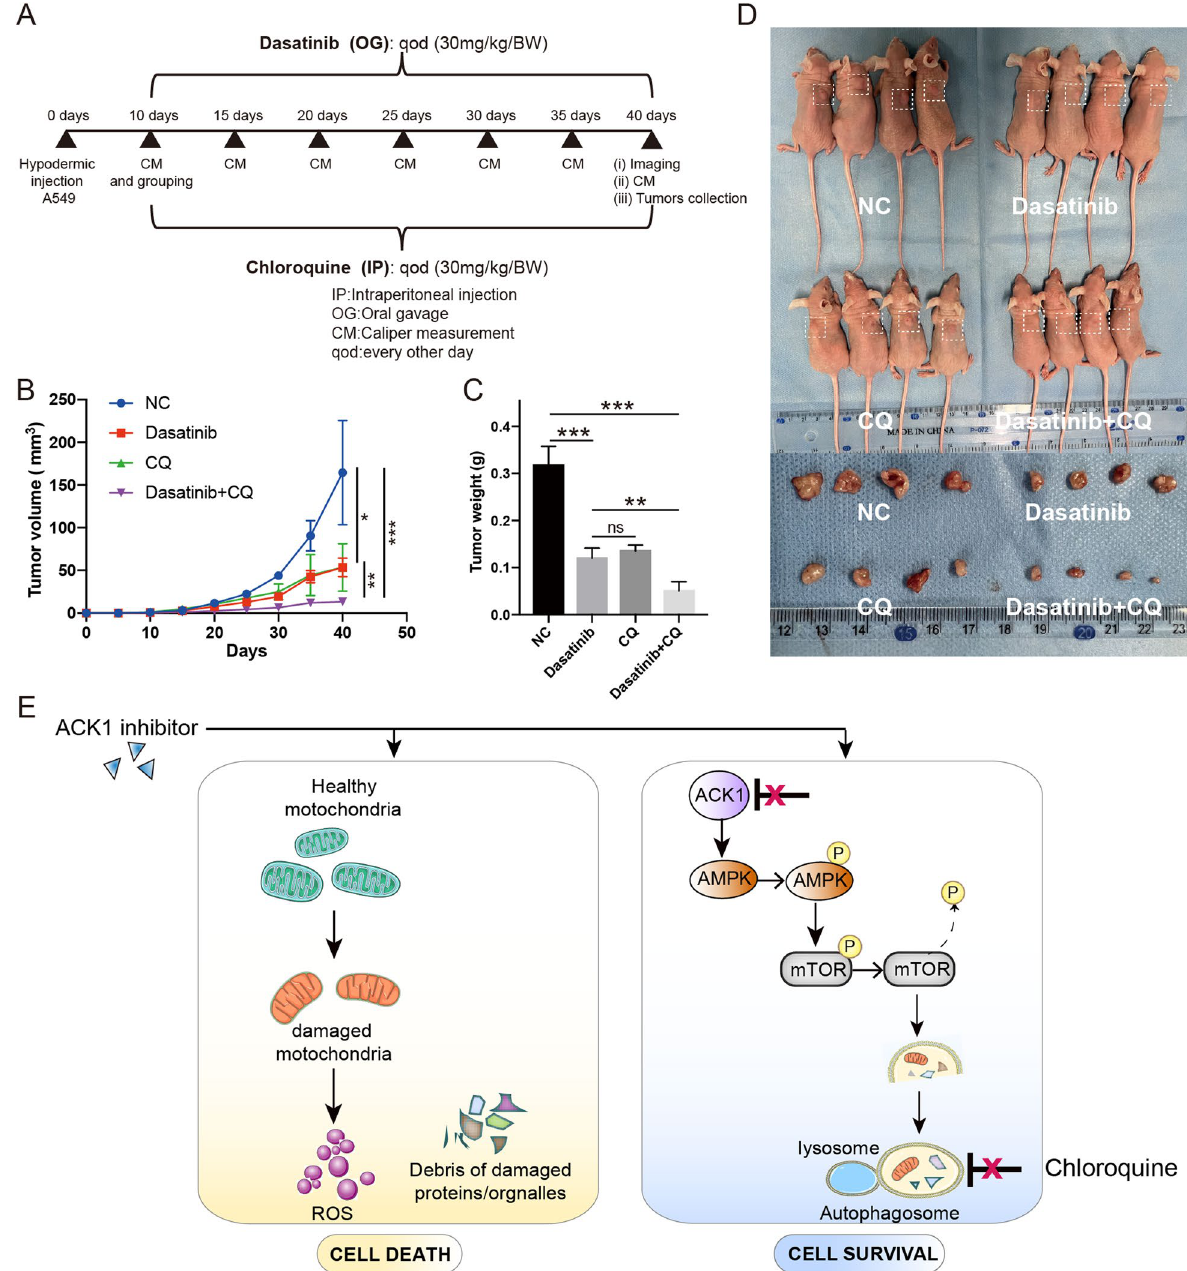
Fig. 9 The combination of Dasatinib and chloroquine reduced tumor volume and weights in an A549 cell-derived xenograft model. A A Schematic diagram of the animal study. B Caliper measurement of tumor volumes for different groups at the indicated time points. C The average weight of mice was measured at the endpoint. D The upper row exhibits mice administrated with vehicle control; Dasatinib, chloroquine (CQ), and a combination of Dasatinib and CQ. The lower row shows tumors collected from corresponding mice. E The schematic mechanism on the left panel showed that the ACK1 inhibitor killed tumor cells by partially impairing cellular organelles and proteins. Damaged organelles lead cells to death by partly generating reactive oxygen species (ROS). The left panel indicated that upon treating the ACK1 inhibitor, the adaptive autophagy-like response cleared damaged cellular organelles and proteins, eradicated oxidative damages, and provided nutritional needs, consequently maintaining homeostasis and cell survival. CQ inhibited ACK1 inhibitor-triggered protective autophagy-like response. *P < 0.05, **P < 0.01, ***P <